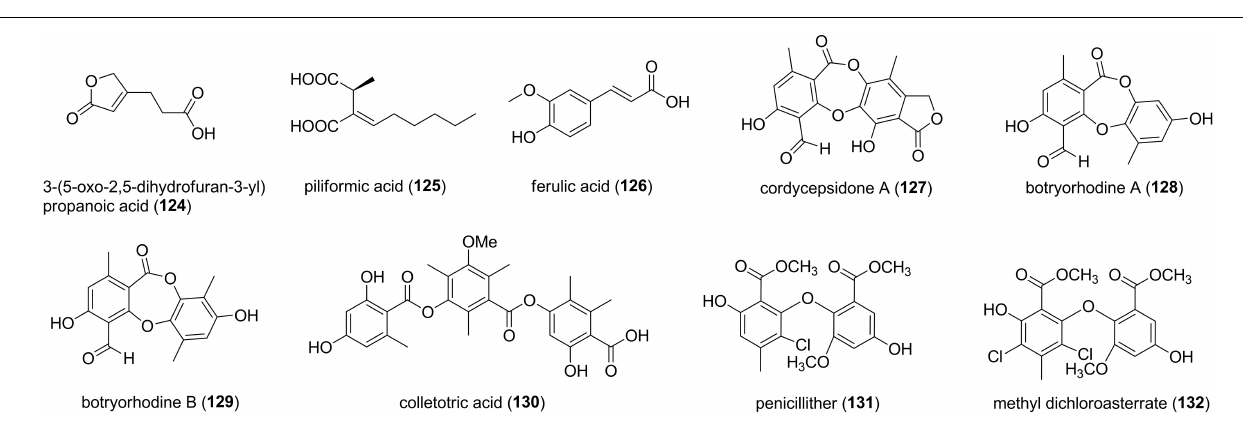
FIGURE 7 | Miscellaneous compounds characterized from endophytic fungi